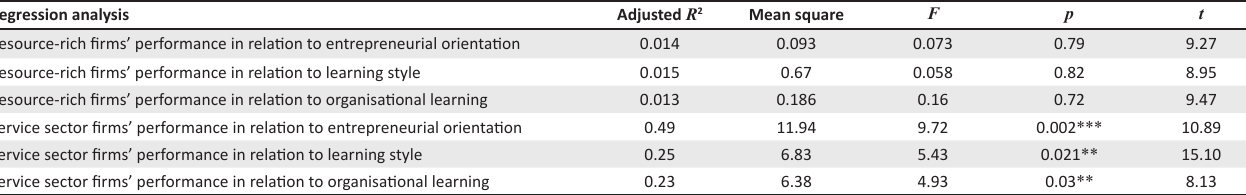
TABLE 2: Regression analysis of sector performance. Regression